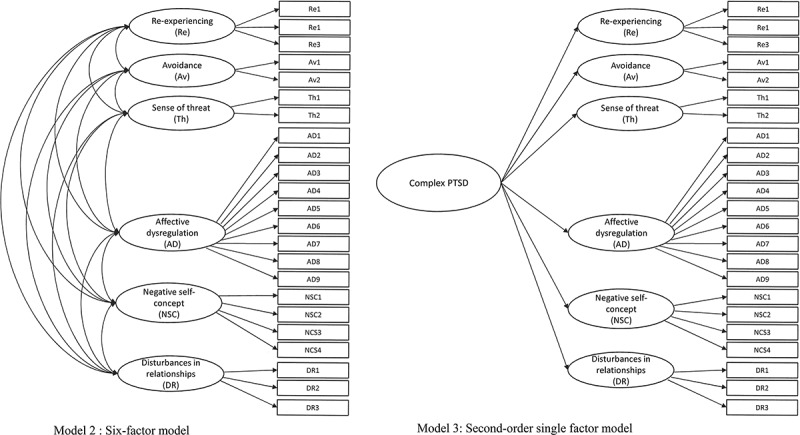
Confirmatory factor analysis of the alternative models of PTSD and DSO symptoms.